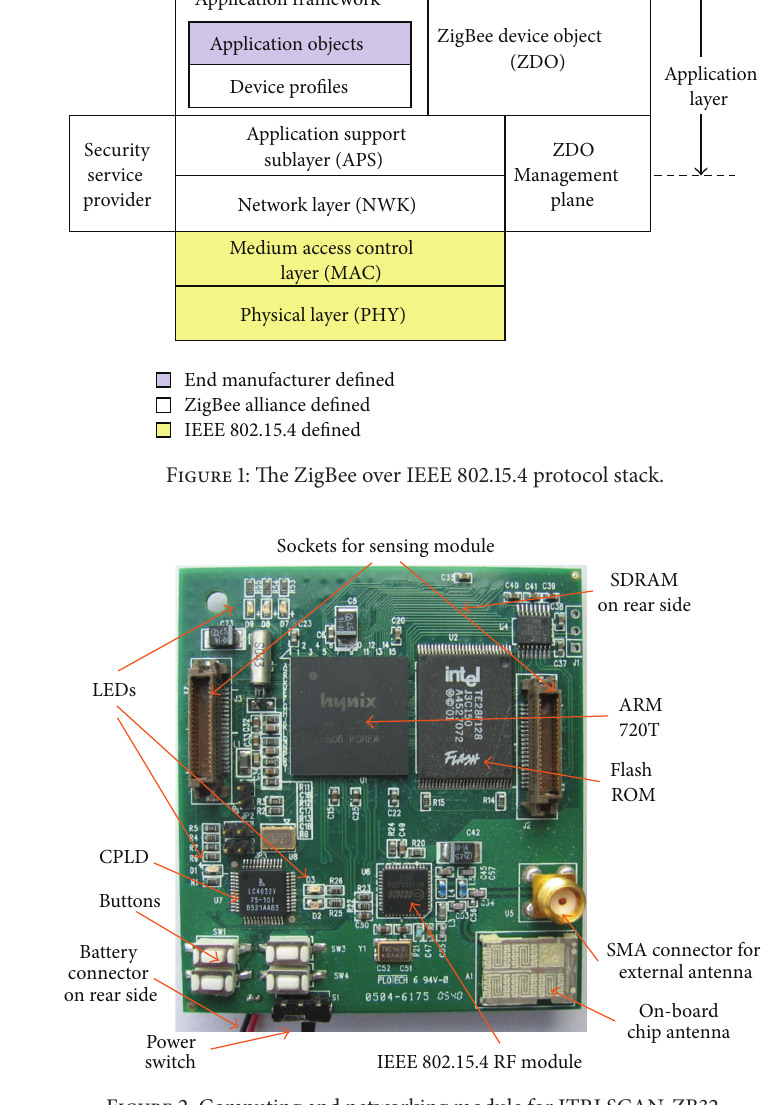
Figure 2: Computing and networking module for ITRI